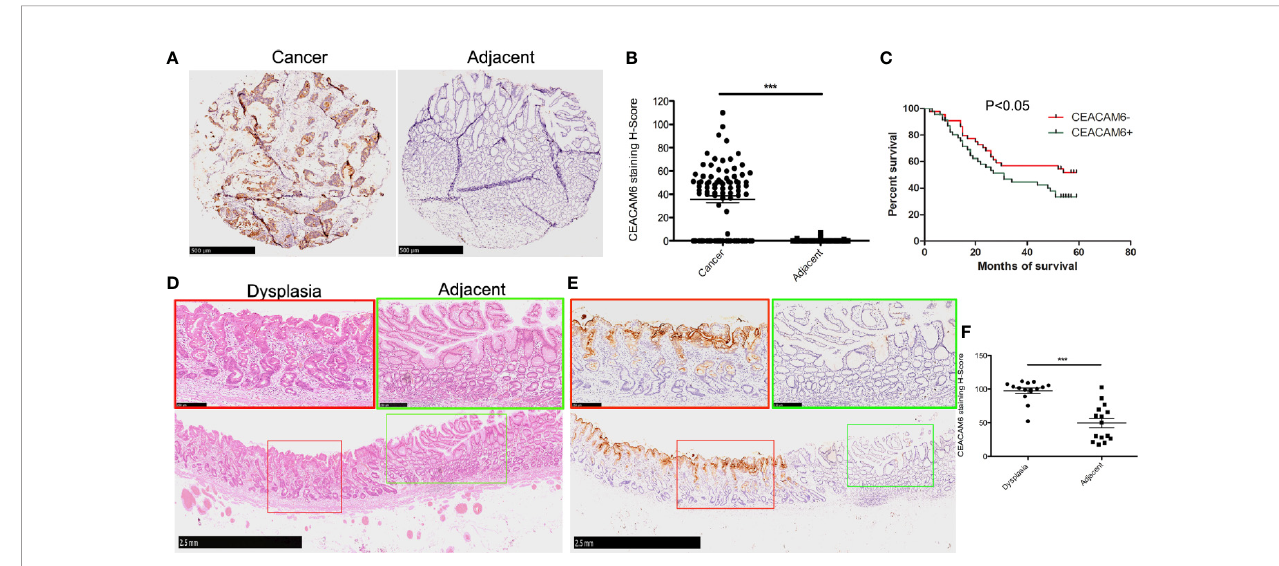
FIGURE 2 | The CEACAM6 expression in the cancer tissues and dysplastic gastric mucosa. (A) Immunohistochemical staining (IHC) was performed to examine the expression of CEACAM6 in tumor and tumor-adjacent tissues using tissue chips. The tissues expressed CEACAM6 were stained in brown. Scale bars = 500 m m. (B) The histograms showed the quanti fi cation of IHC staining. Bar represents the Mean (± SEM) of staining H-Score (n=89). ***P<0.001. (C) The survival curve was drawn according to the CEACAM6 expression data got from the IHC analysis above. (D) HE staining was performed on the ESD specimen, the normal mucosa had the regular glands (green box), the mucosa with dysplastic changes had the disordered arrangement of glands and large hyperchromatic nuclei (red box), Scale bars = 2.5 mm. The fi elds in the green or red boxes were magni fi ed and shown on the upper panel, Scale bars = 250 m m. (E) IHC was performed to examine the expression of CEACAM6 in the dysplastic gastric mucosa got from ESD operation, the tissues expressed CEACAM6 were stained in brown, Scale bars = 2.5 mm, and the fi elds in the red or green box were magni fi ed and shown on the upper panel, Scale bars = 250 m m. (F) The histograms showed the quanti fi cation of IHC staining, the data are expressed as the mean (± SEM) of staining H-Score (n = 15, mild dysplasia=5, moderate dysplasia=5, severe dysplasia=5). ***P<0.001. All immunohistochemical sections were scanned by 3D HISTECH (pannoramic MIDI) and 10 randomly selected fi elds were checked under pannoramic viewer, the percentage of positive cells was analyzed by the densito quant software and the staining H-Score was